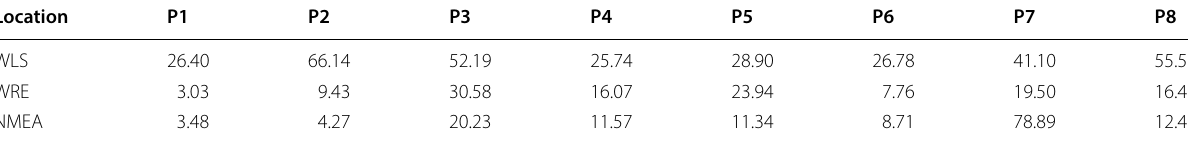
Table 5 The mean error of different positioning approaches (m) Location